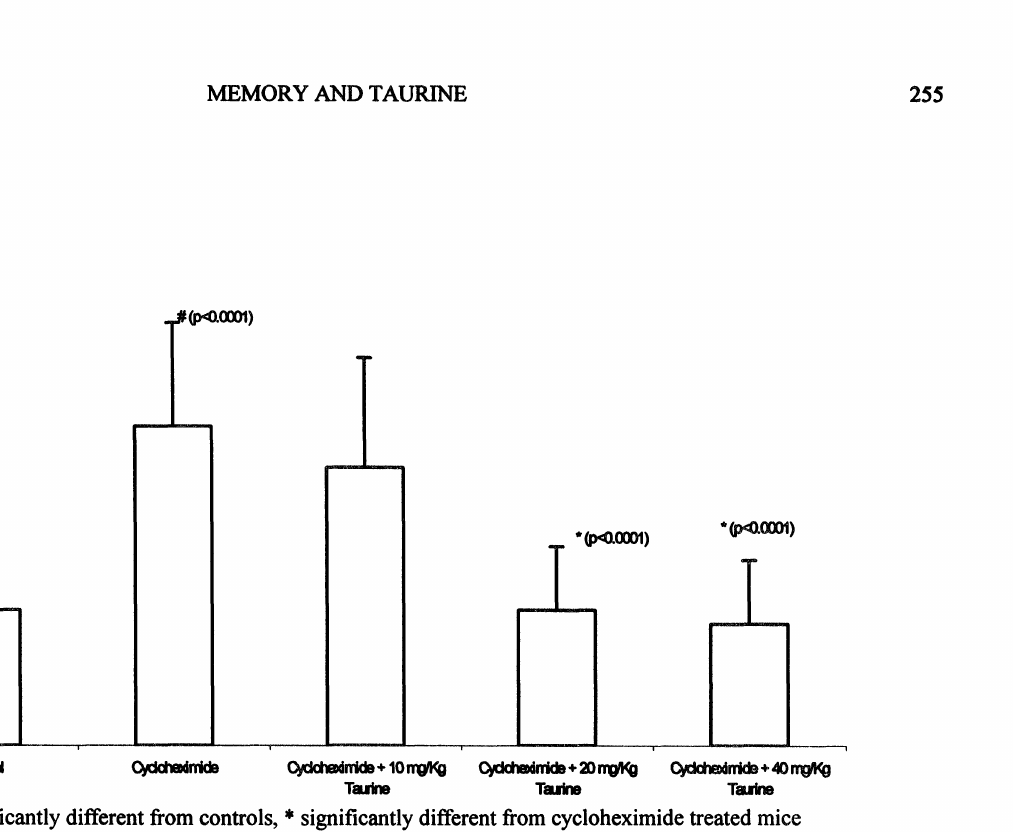
Fig. 12: Effect of 30 days oftaurine treatment on escape latency in cycloheximide-treated mice